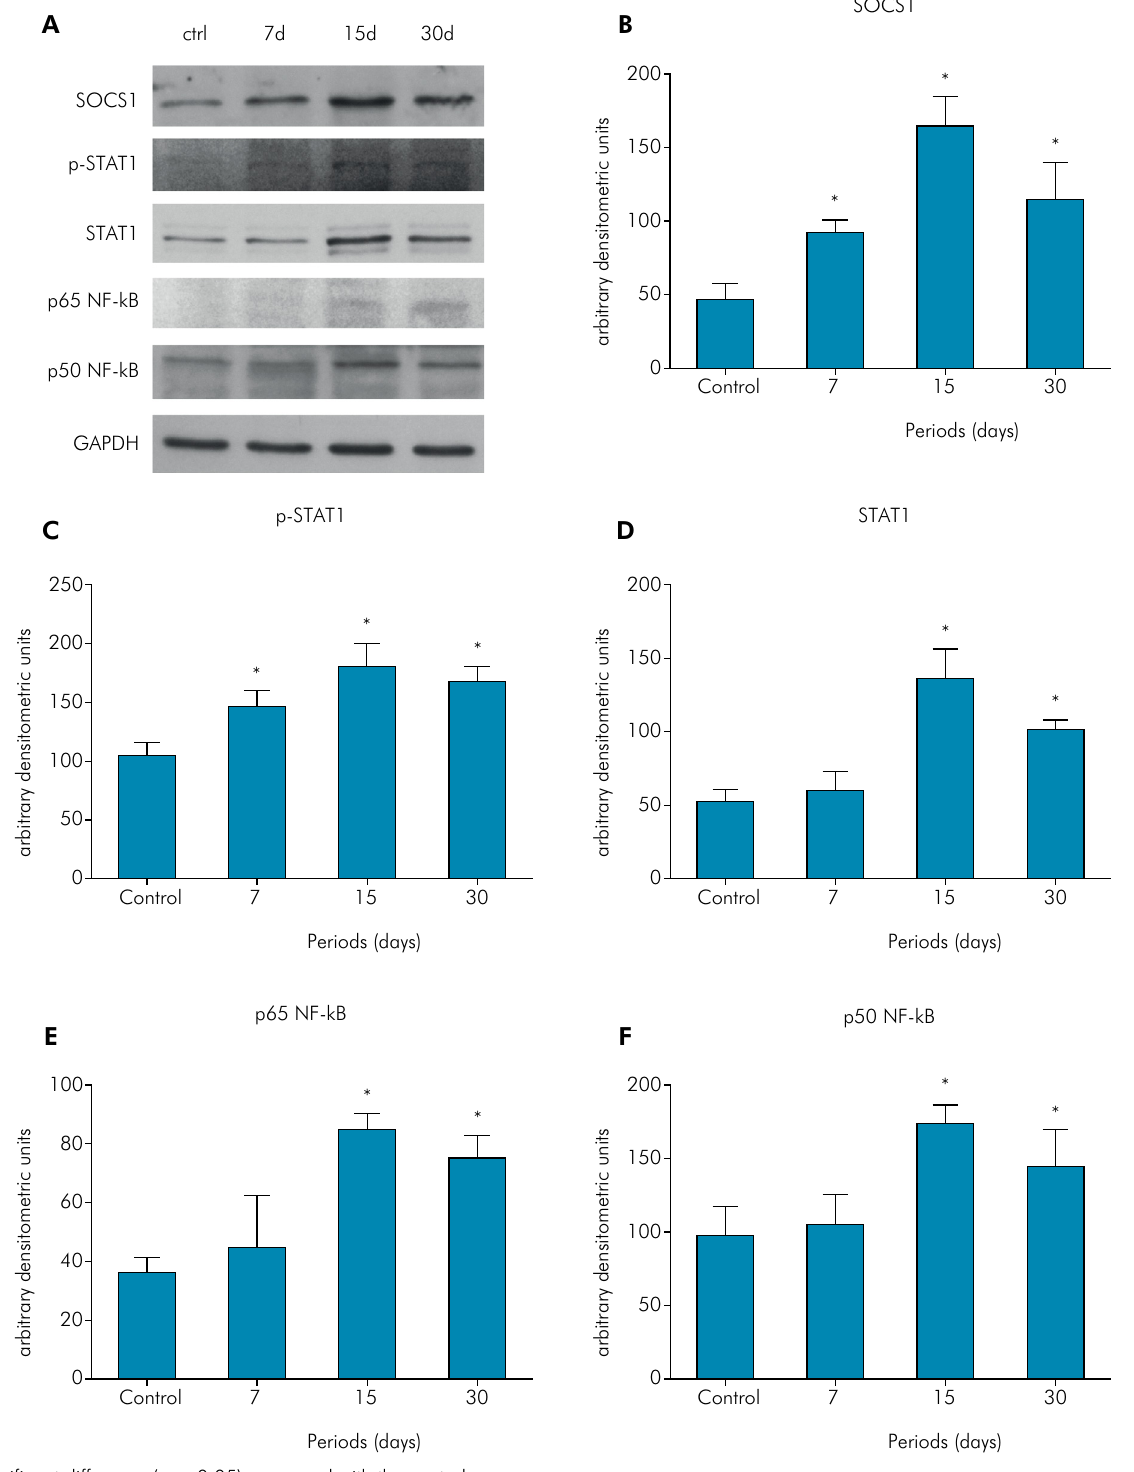
* Significant difference (p < 0.05) compared with the control. Figure 4. (A) Western blot analysis revealed that SOCS1 expression and STAT1 and NF- κ B activation were increased after 7 days in the experimental group, peaking at 15 days. Densitometric analysis of the Western blot results indicated sustained activation of SOCS1 (B), STAT1 (C, D), and NF- κ B (E, F) at LPS injection sites beginning at day 7 and peaking at day 15. The bars represent the mean normalized arbitrary densitometric units of six independent samples for each period, and vertical lines show the standard